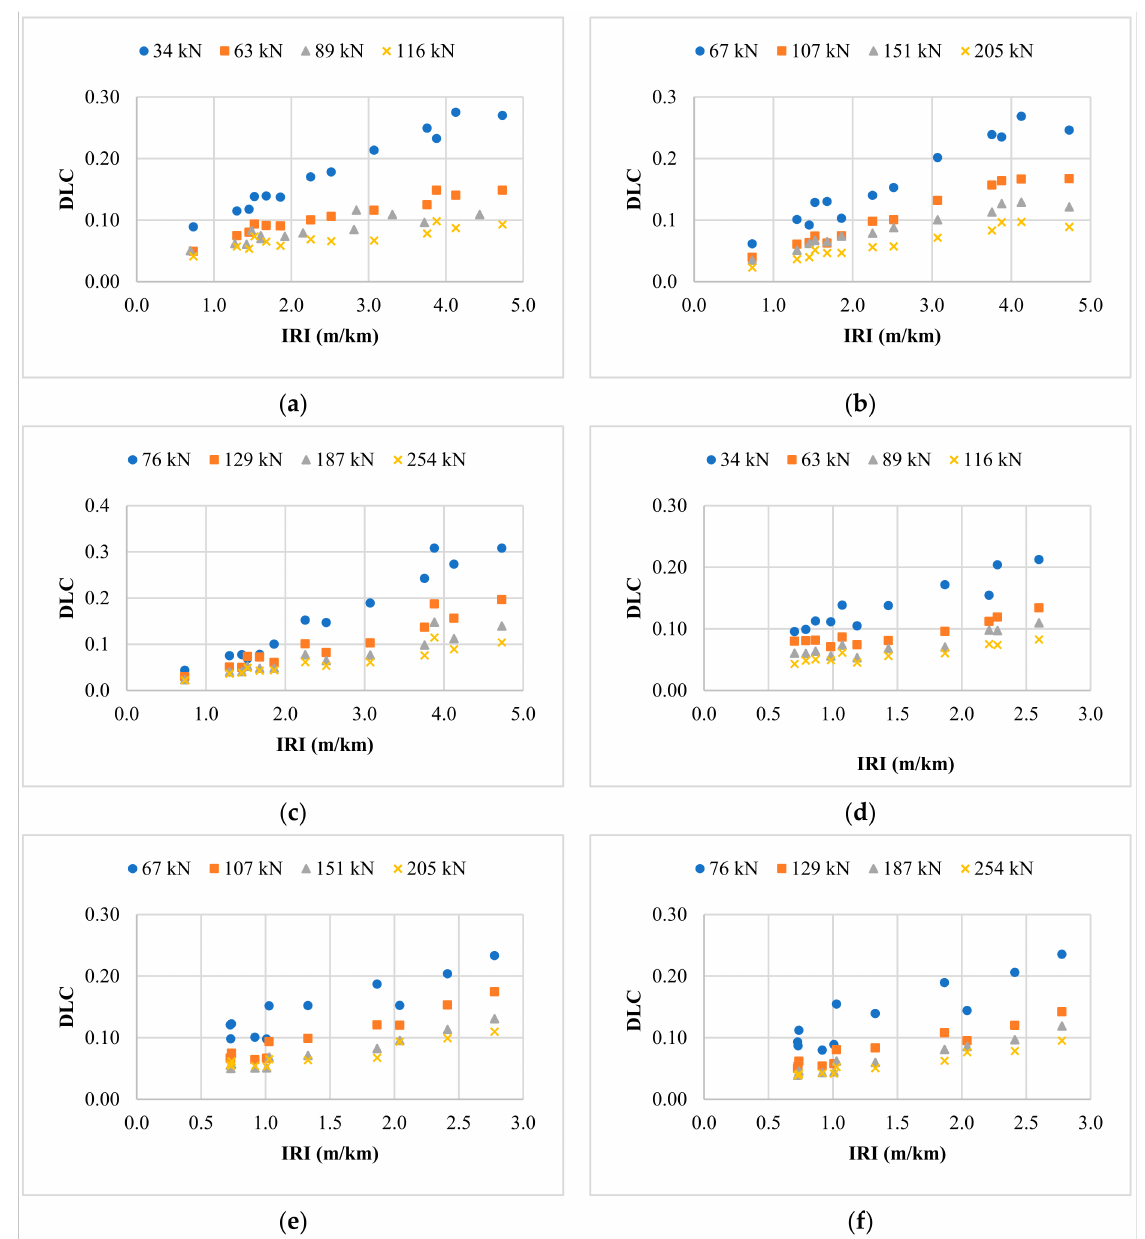
Figure 3. Change of DLC with IRI and axle loads: ( a ) single axle (minor); ( b ) tandem axle (minor); ( c ) tridem axle (minor); ( d ) single axle (major); ( e ) tandem axle (major); and ( f ) tridem axle (major). Based on the calculated DLCs, a nonlinear regression model was fitted with respect to axle load and pavement roughness for each axle type, as expressed by Equation (1). The vehicle speed was not included as a continuous variable in the regression model since two different speeds were considered for major and minor highways, respectively.